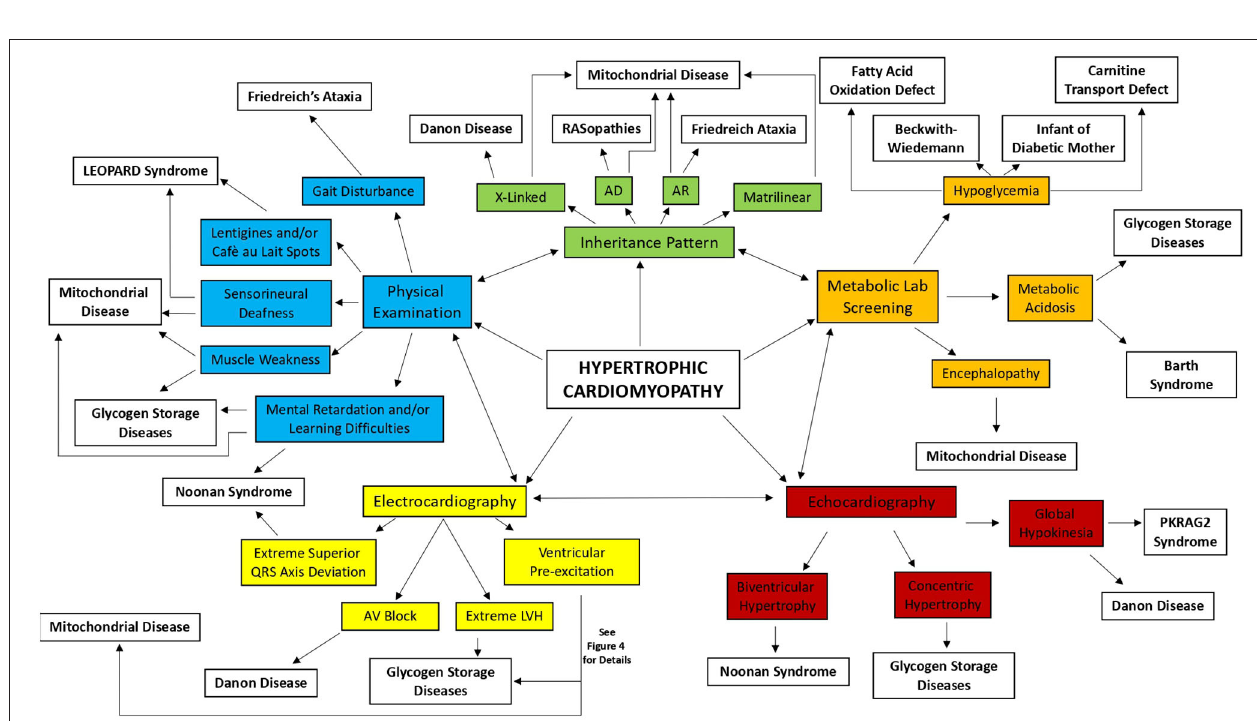
FIGURE 2 | Diagnostic approach for the infant and young child with hypertrophic cardiomyopathy. AD, autosomal dominant; AR, autosomal recessive; AV, atrioventricular; LVH, left ventricular hypertrophy.